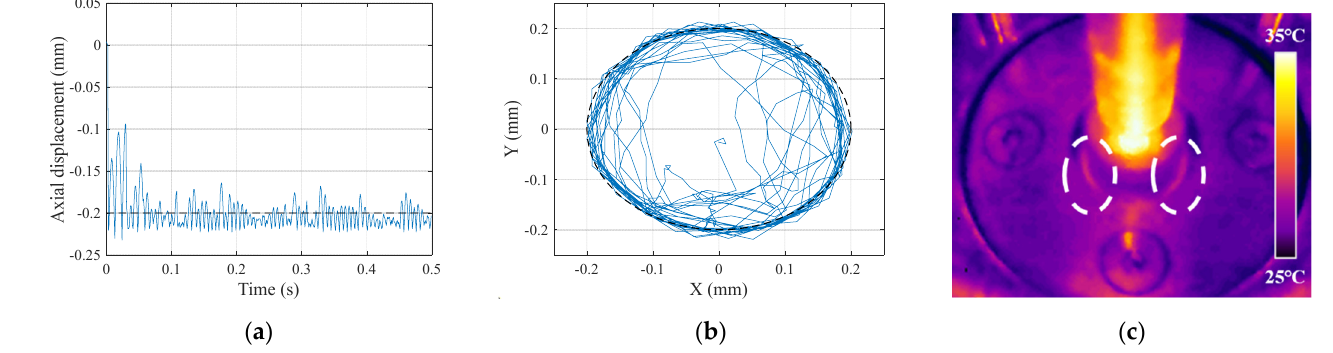
Figure 11. Experimentally measured rotor drop process: ( a ) Axial displacement, ( b ) Radial trajectory, and ( c ) Temperature change (The circle shows the position of TDB).